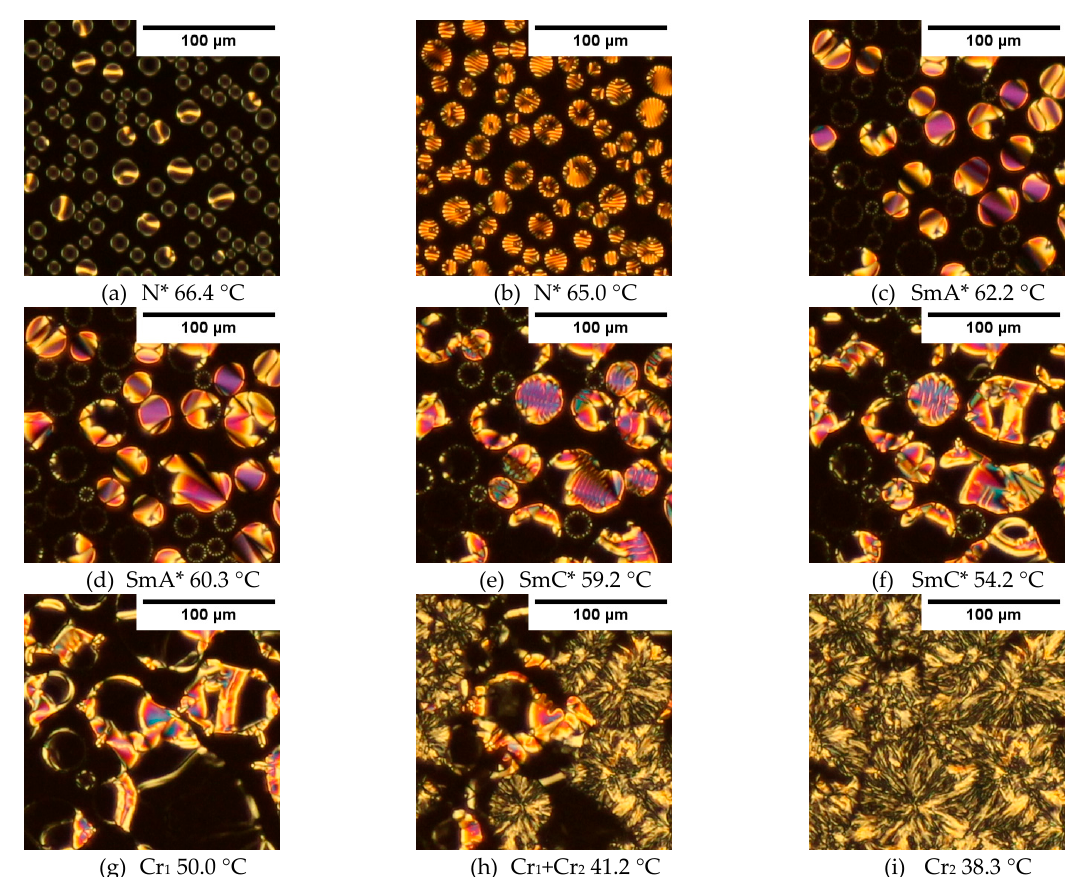
Figure 8. Textures of Composite 6 registered during cooling at a rate of 2 °C/min in the N* ( a , b ), SmA* ( c , d ), SmC* ( e , f ) and crystalline phases ( g – i ).